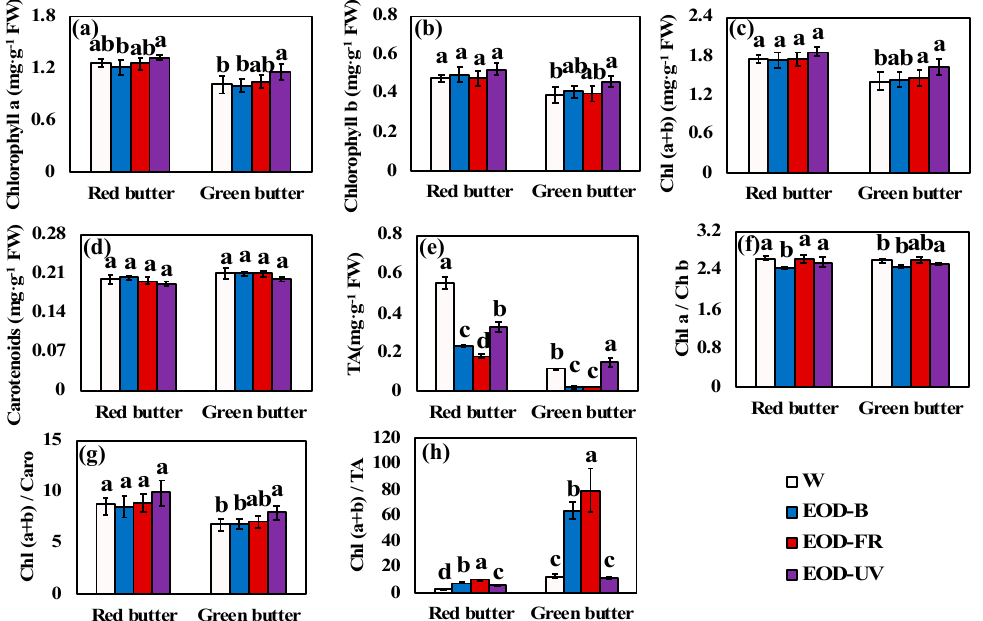
Figure 6. Pigment contents of lettuce under di ff erent end-of-day lightings. ( a – e ) were the pigment contents of lettuce. ( f – h ) were the pigment ratio. Di ff erent letters on the top of the columns indicate significant di ff erences at p < 0.05 according to one-way ANOVA, Tukey’s honest significant di ff erence tests. W = day-white light, EOD-B = end-of-day enhanced blue light, EOD-FR = end-of-day far-red light, EOD-UV = end-of-day ultraviolet-A light. FW = fresh weight, Chl = chlorophyll, TA = total anthocyanins, Caro = carotenoids. Table 4. The interaction effects of cultivars and lightings on lettuce pigments. Pigments Pigment Ratio Interaction